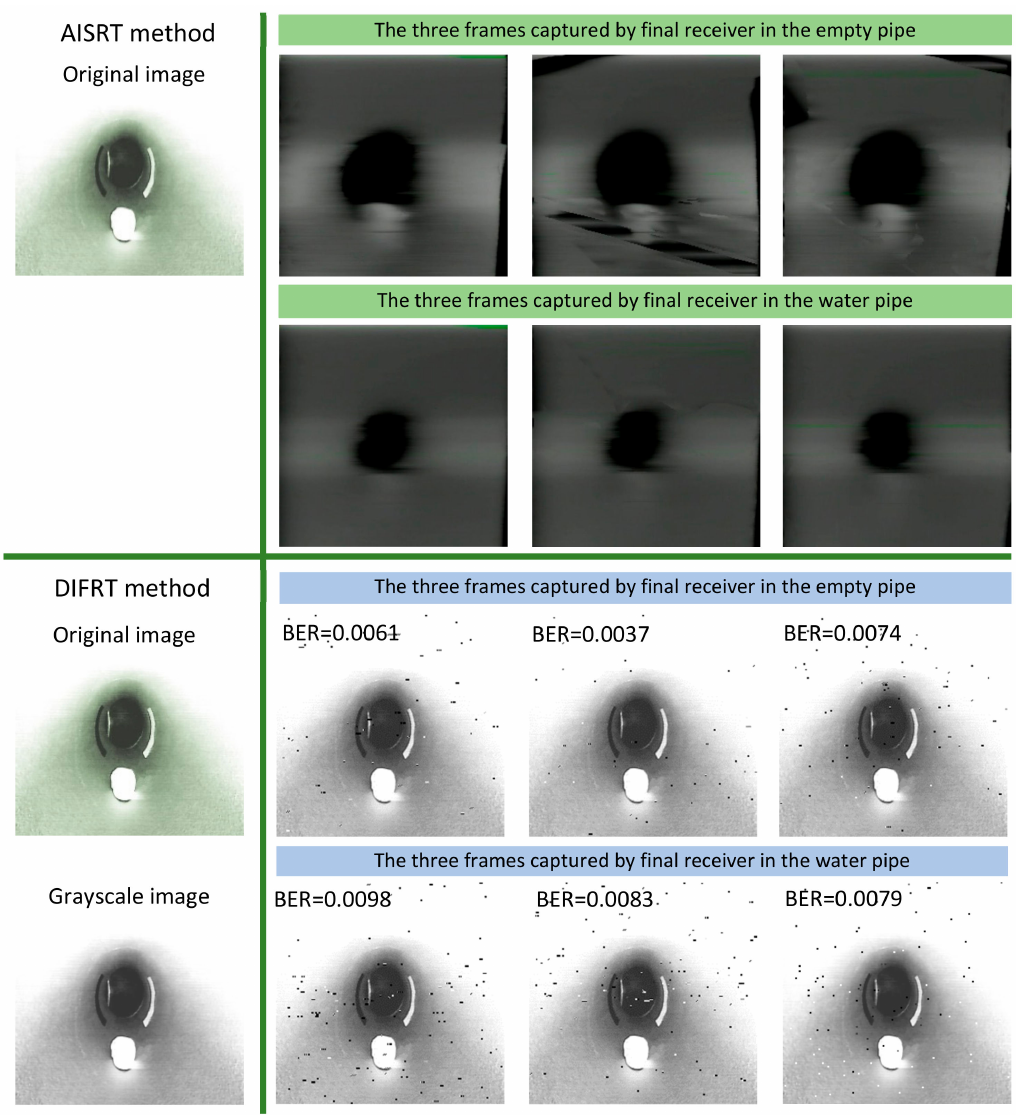
Figure 11. The performance comparison between DIFRT and